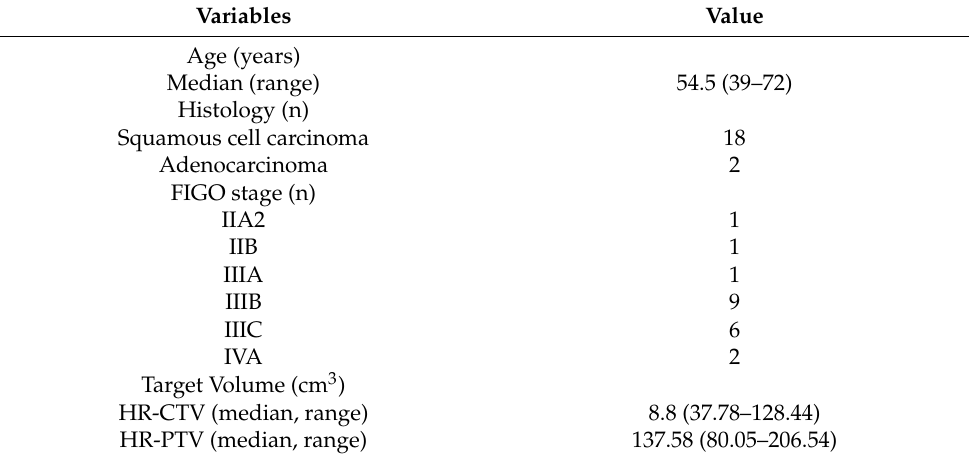
FIGO, International Federation of Gynecology and Obstetrics; HR-CTV, high-risk clinical target volume; HR-PTV, high-risk planning target